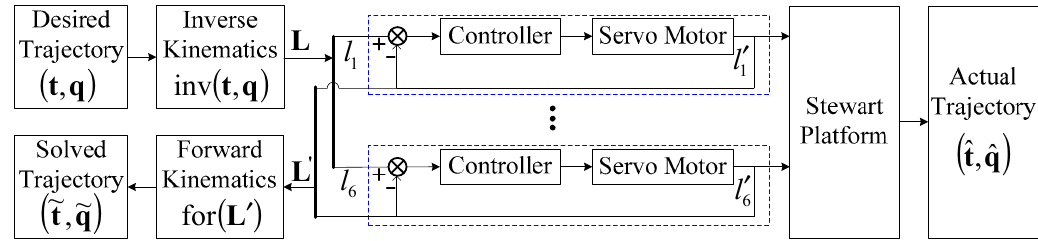
Figure 2. Control and measure of the position and orientation of the Stewart platform.